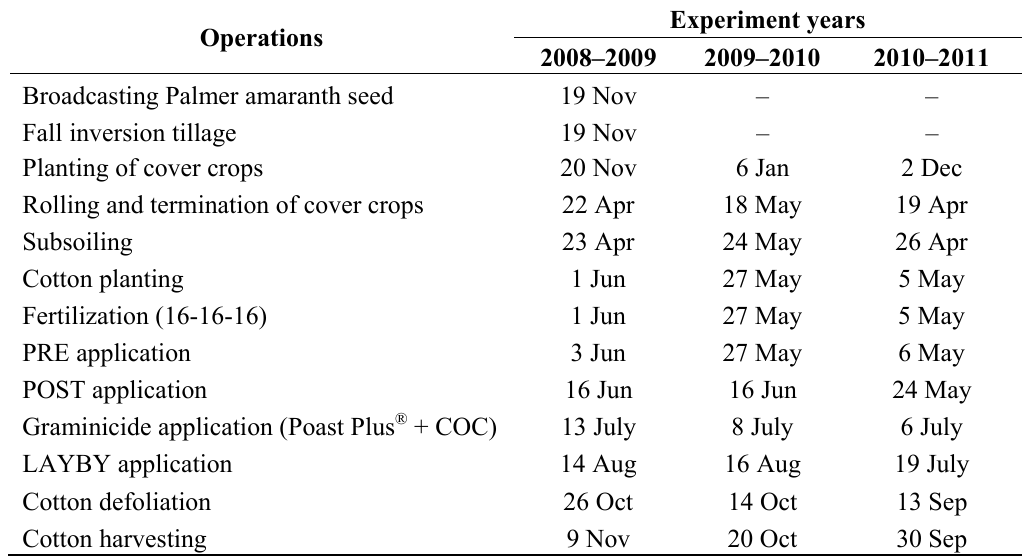
Table 1. Table 1. Schedule of operations performed during the